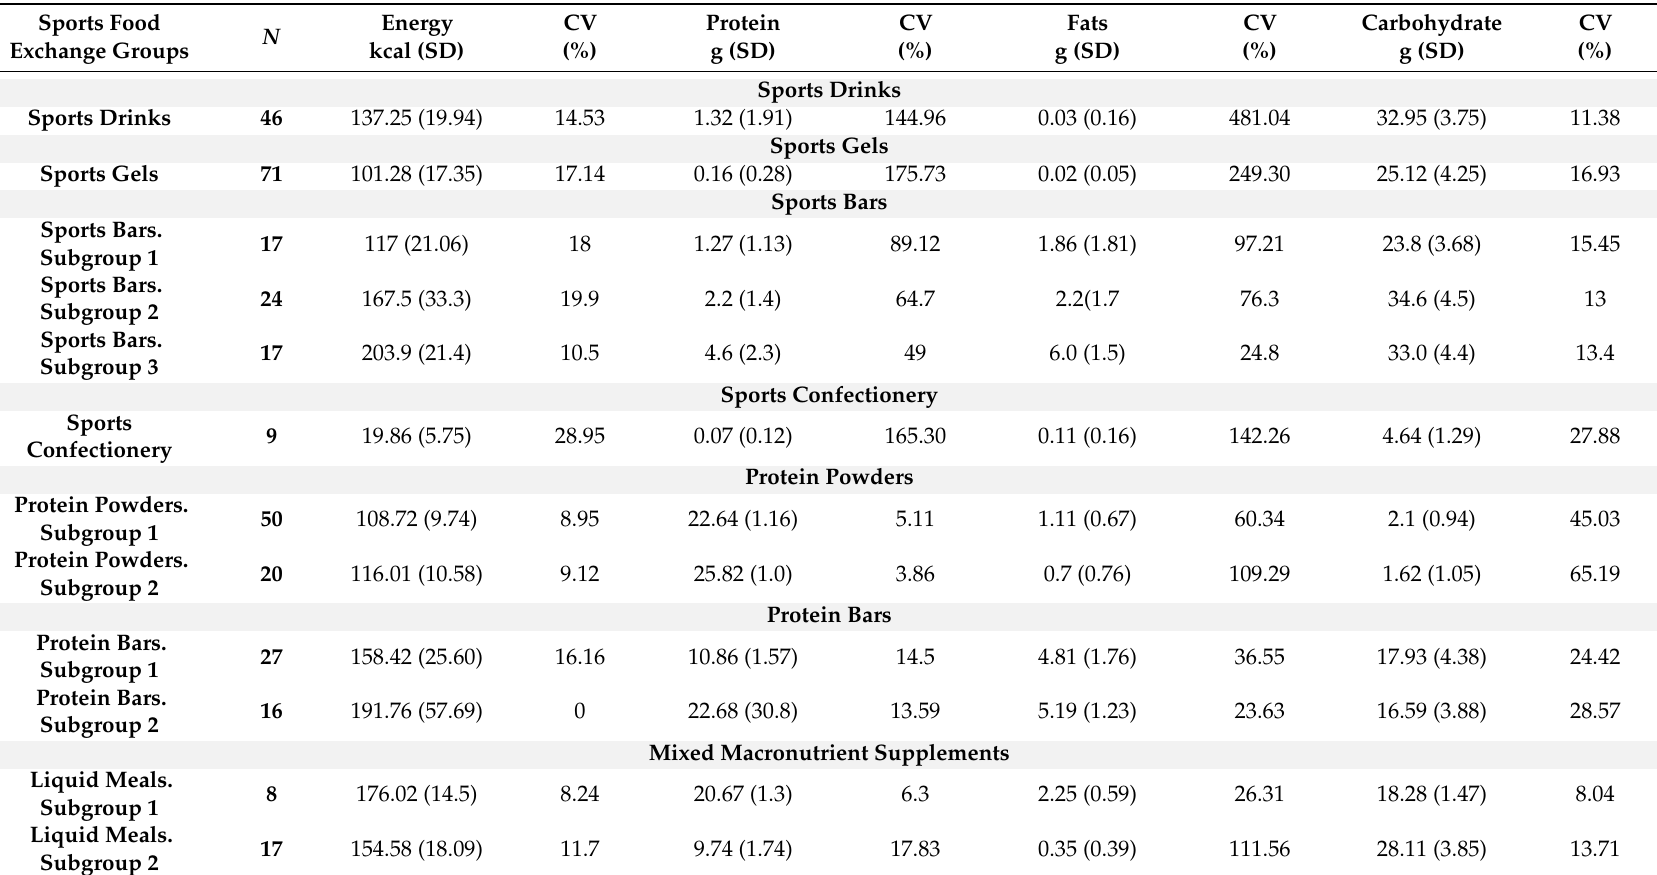
Table 3. Mean, standard deviation, and coe ffi cient of variation of energy and macronutrients values of the sports foods groups and subgroups proposed in the exchange